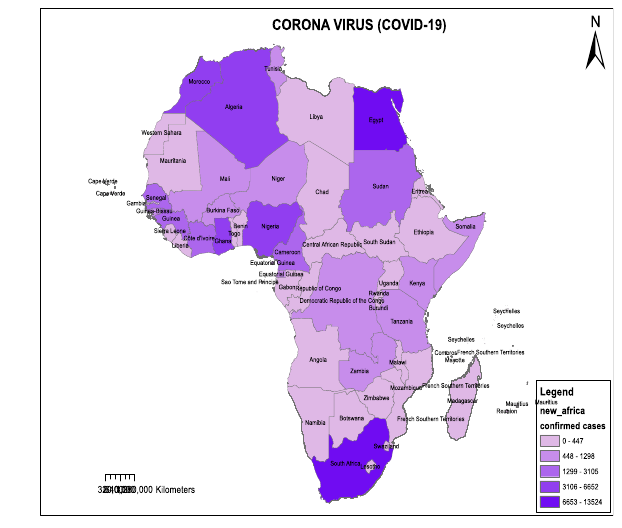
Fig. 11. Drivers of COVID-19 in Asia.